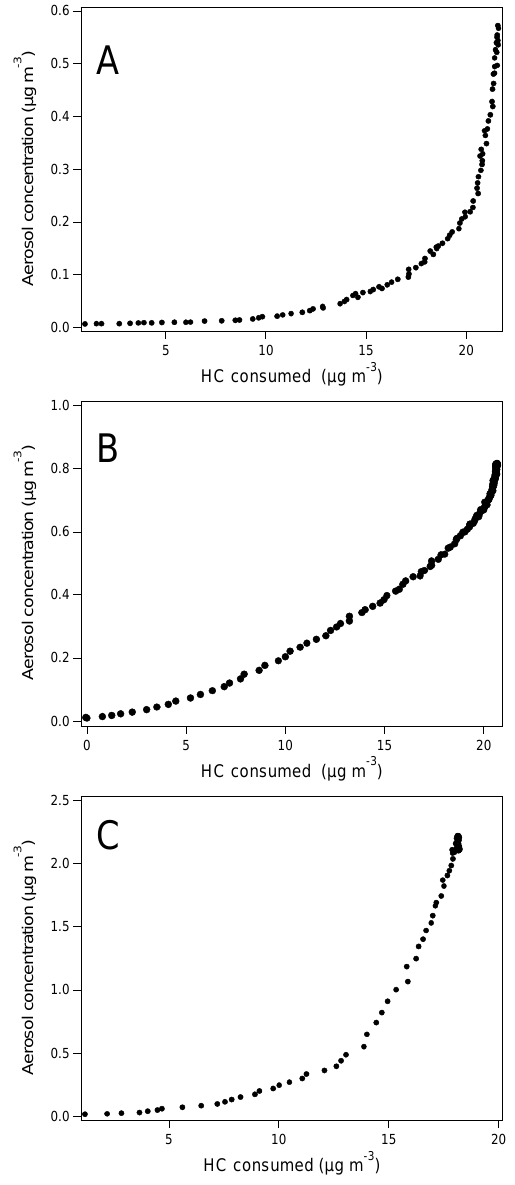
Figure 1. Time-dependent growth curve of aerosols from the OH oxidation of α -pinene (a) , β -pinene (b) and limonene (c) as func- tion of hydrocarbon (HC) consumed (monoterpene here) from mea-